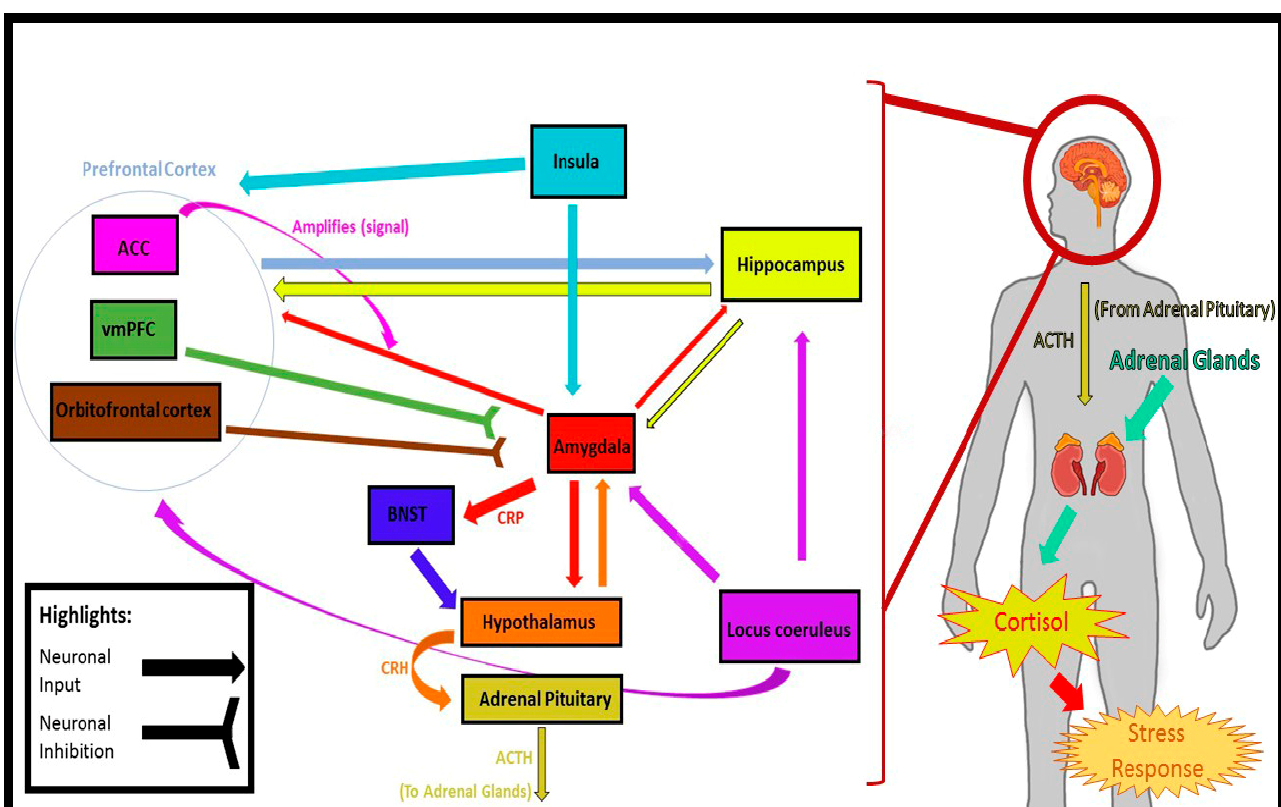
Figure 2. The limbic system areas and respective connections in terms of a stress response (fear/anxiety). While the limbic system is the primary source for a stress response, please note that that these are not the only brain and body systems involved. Midsagittal brain image adapted from gero.usc.edu [89] (accessed on 16 July 2020). HPA axis based on Figure 1 from Tapp et al. [81].